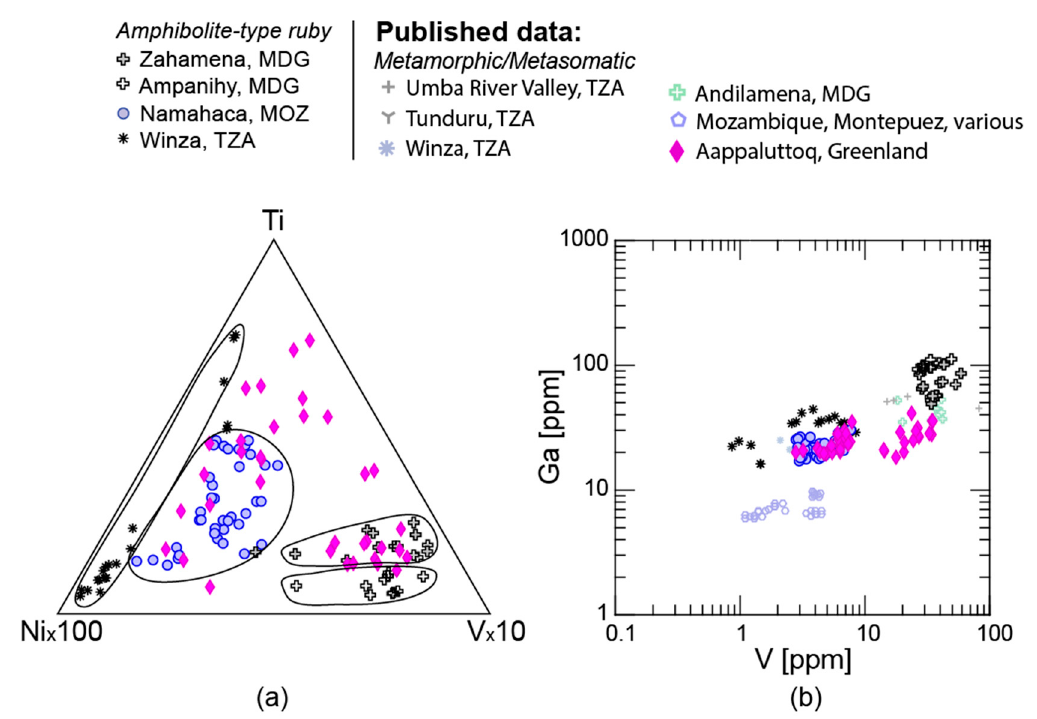
Figure 12. ( a ) Ternary diagram of Ni × 100-Ti-V × 10 for amphibolite-type rubies analyzed using LA-ICP-MS in this study. Greenland data are taken from [12]. ( b ) Binary plot of Ga (ppm) versus V (ppm) abundances in amphibolite-type rubies analyzed in this study. Additional data from [23,25,59]. On the Ga versus V plot, rubies from the Andilamena region in Madagascar [59] plot at slightly lower Ga values than those analyzed in this study. More notably, rubies from Mozambique analyzed by [23] have significantly lower Ga contents than rubies from Mozambique in this study. Both these